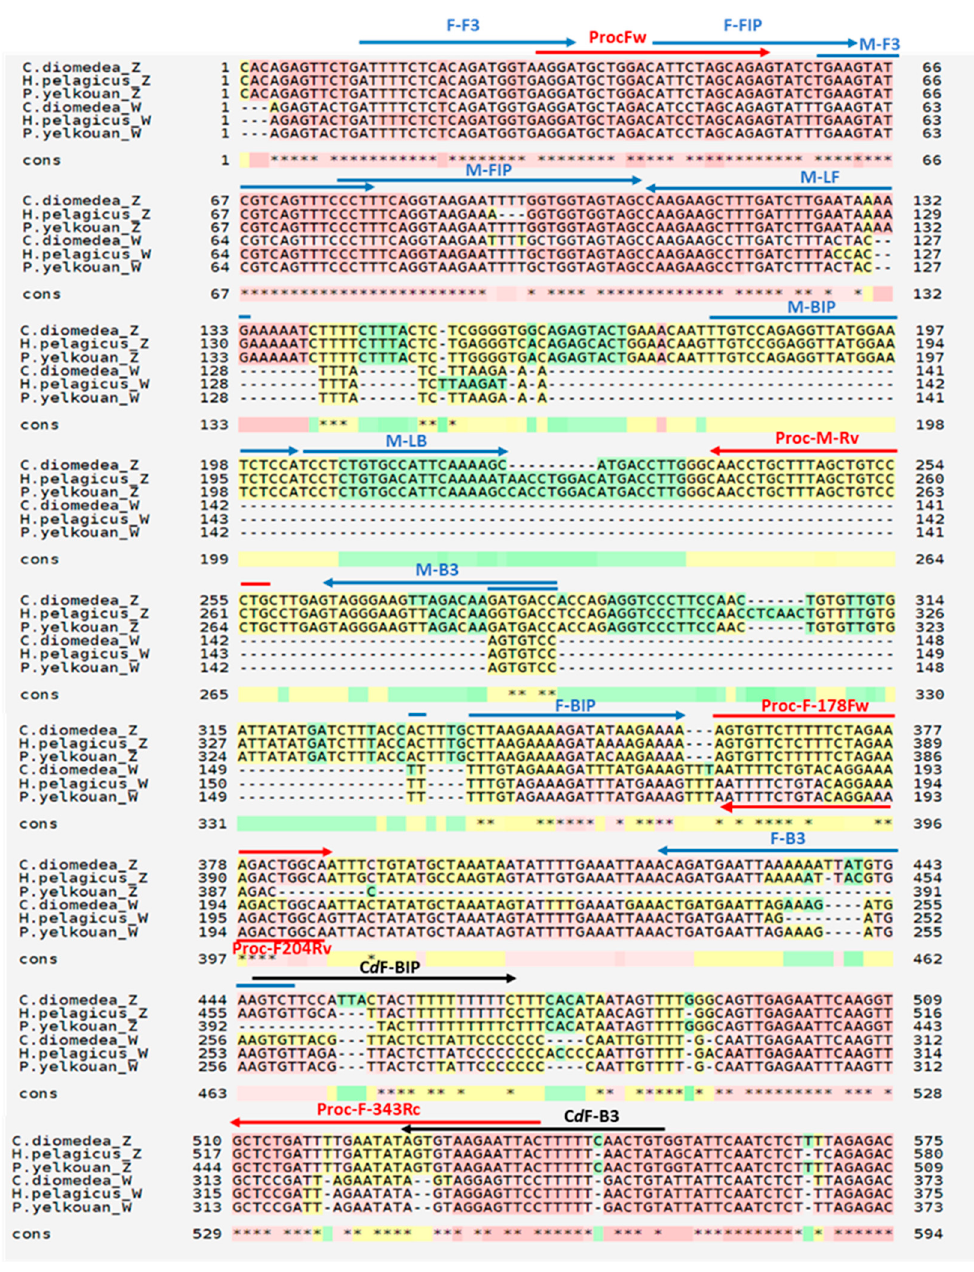
Figure 2. Multiple sequence alignment of CHD-Z and CHD-W of selected Procellariiformes using M-Coffe. Primer sets for PCR and LAMP reported in Table 1 are highlighted as red and blue arrows, respectively. Black arrows indicate C. diomedea female-specific LAMP primers.